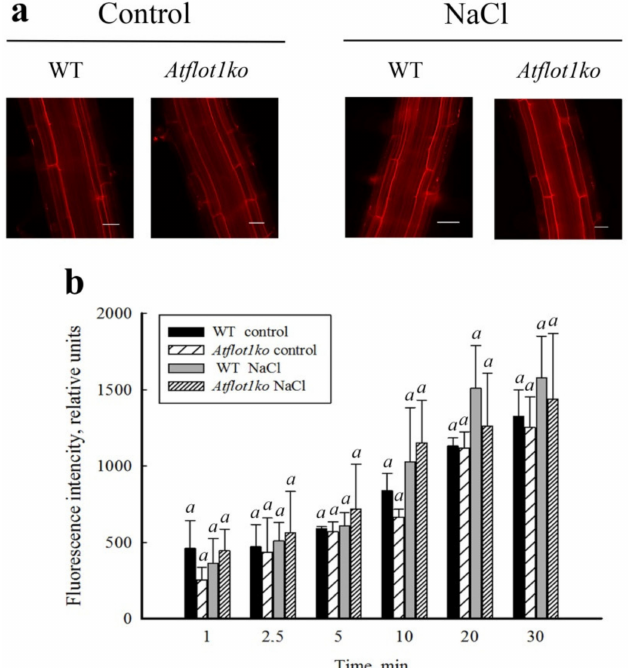
Figure 5. Dynamics of the fluorescent marker FM4-64 uptake by roots of 5-day-old A. thaliana seedlings incubated in 1 MS medium containing 2 µ M of FM4-64, either in the absence or presence of 2 NaCl. ( a ) Color images show the intensity of FM4-64 fluorescence in root cells 30 min after incubation in a dye solution. ( b ) A time course of FM4-64 uptake by roots of 5-day-old A. thaliana seedlings. Means ± SE of FM4-64 fluorescence intensity in roots in 3 independent experiments using 50 roots in every experiment are given. Scale—20 µ m. Identical letters indicate no difference between mean values in each group (one-way ANOVA, p <